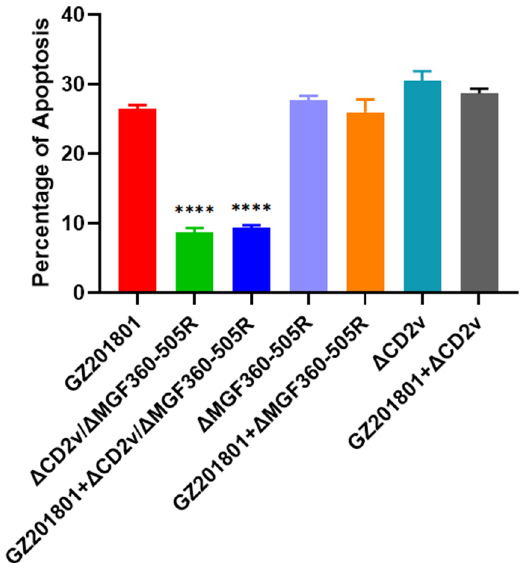
Figure 3. The apoptosis of GZ201801-ASFV, Δ CD2v/ Δ MGF360-505R-ASFV, Δ MGF360-505R-ASFV, and Δ CD2v-ASFV are infected in primary PAMs. GZ201801-ASFV caused 26.49% of cell apoptosis after infection with PAMs, Δ CD2v/ Δ MGF360-505R-ASFV caused 8.72% of cell apoptosis after infection with PAMs, Δ MGF360-505R-ASFV caused 27.67% of cell apoptosis after infection with PAMs, Δ CD2v caused 30.45% of cell apoptosis after infection with PAMs, GZ201801-ASFV and Δ CD2v/ Δ MGF360-505R-ASFV caused 9.35% of cell apoptosis after co-infection with PAMs, GZ201801-ASFV and Δ MGF360-505R-ASFV caused 27.67% of cell apoptosis after co-infection with PAMs, and GZ201801-ASFV and Δ CD2v caused 30.45% of cell apoptosis after co-infection with PAMs. PAMs were either infected with GZ201801-ASFV, Δ CD2v/ Δ MGF360-505R-ASFV, Δ MGF360- 505R-ASFV, or Δ CD2v-ASFV at a MOI of 0.1. Significant differences compared with the control group are denoted by **** ( p < 0.001).